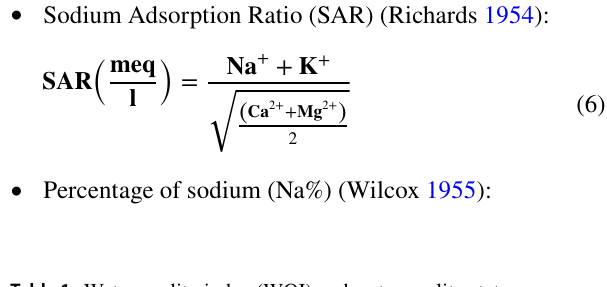
Table 1 Water quality index (WQI) and water quality